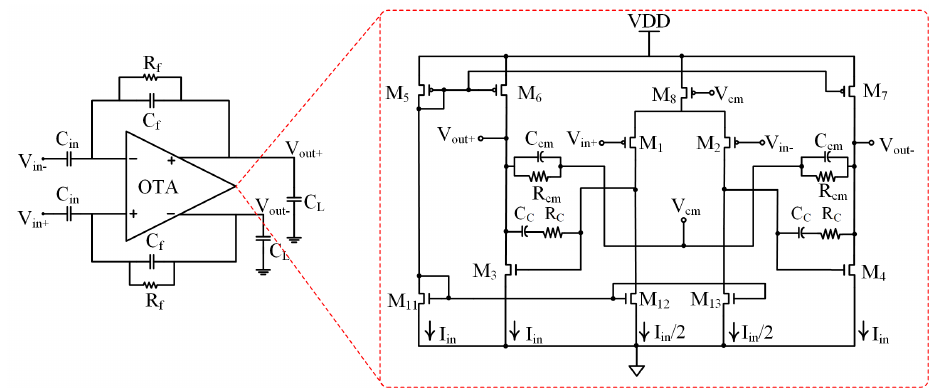
Figure 2. Schematic of the amplifier with the operational transconductance amplifier